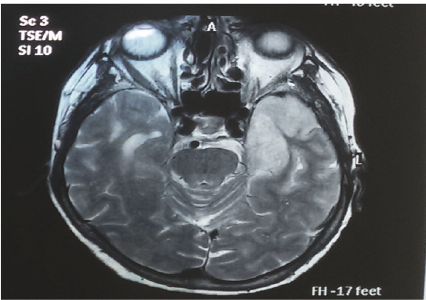
Figure 1: Hyperintense depiction of the left temporal lobe and the insula in T2WI sequence of brain MRI scan, indicative for HSV